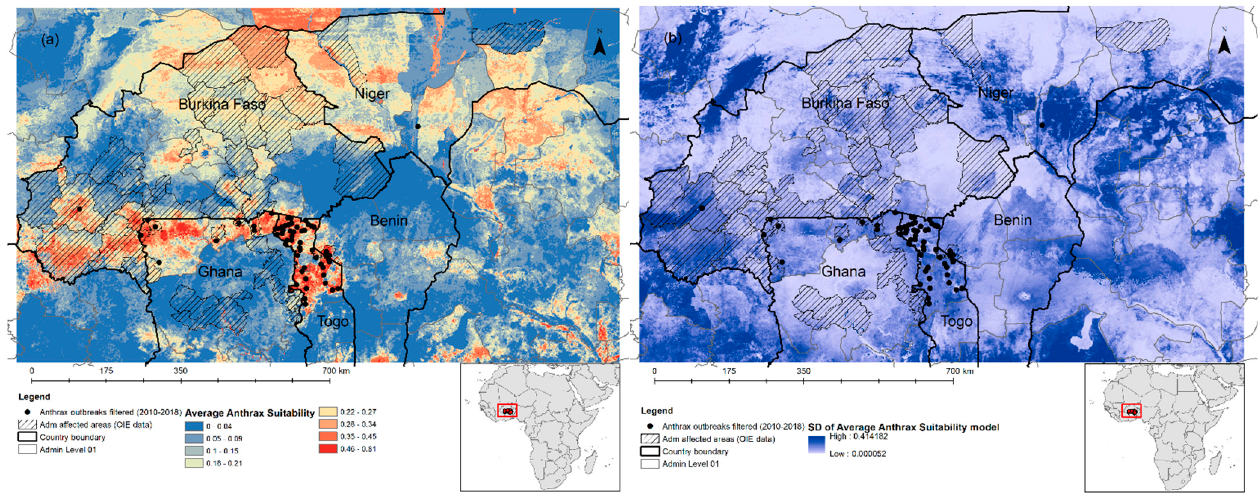
Figure 6. ( a ) The predicted suitability of anthrax presence (average model) and ( b ) its standard deviation based on 9 selected and uncorrelated variables. Table 3. Contribution of the predictors to the MaxEnt model (averages over 10